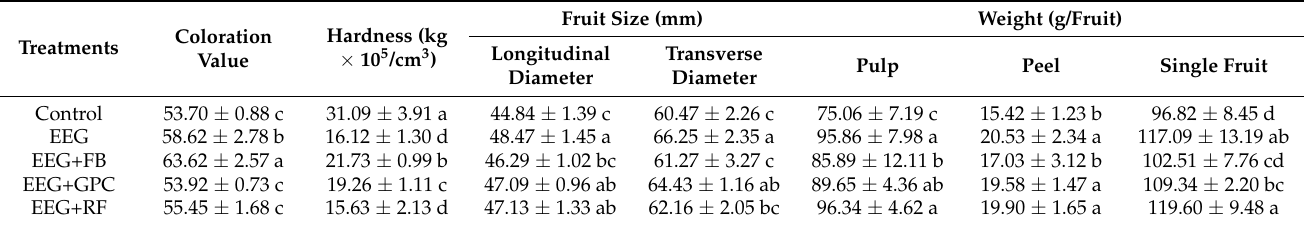
Table 2. Effects of foliar spraying easily extractable glomalin-related soil protein in combination with agronomic strategies on the internal quality of fruits in Satsuma mandarin “Oita 4”.